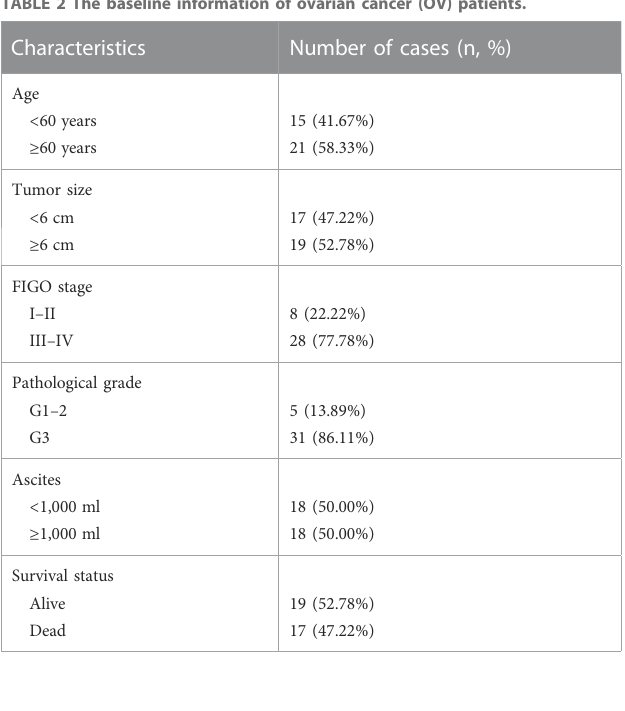
TABLE 2 The baseline information of ovarian cancer (OV) patients.